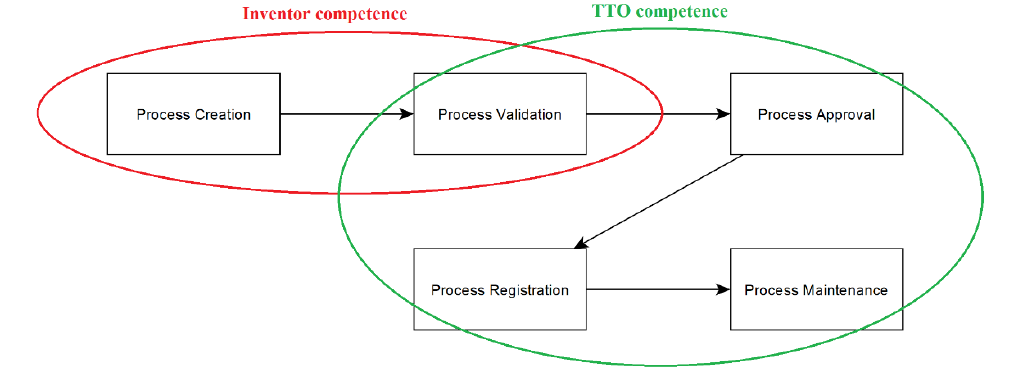
Figure 2. Processes of state model.